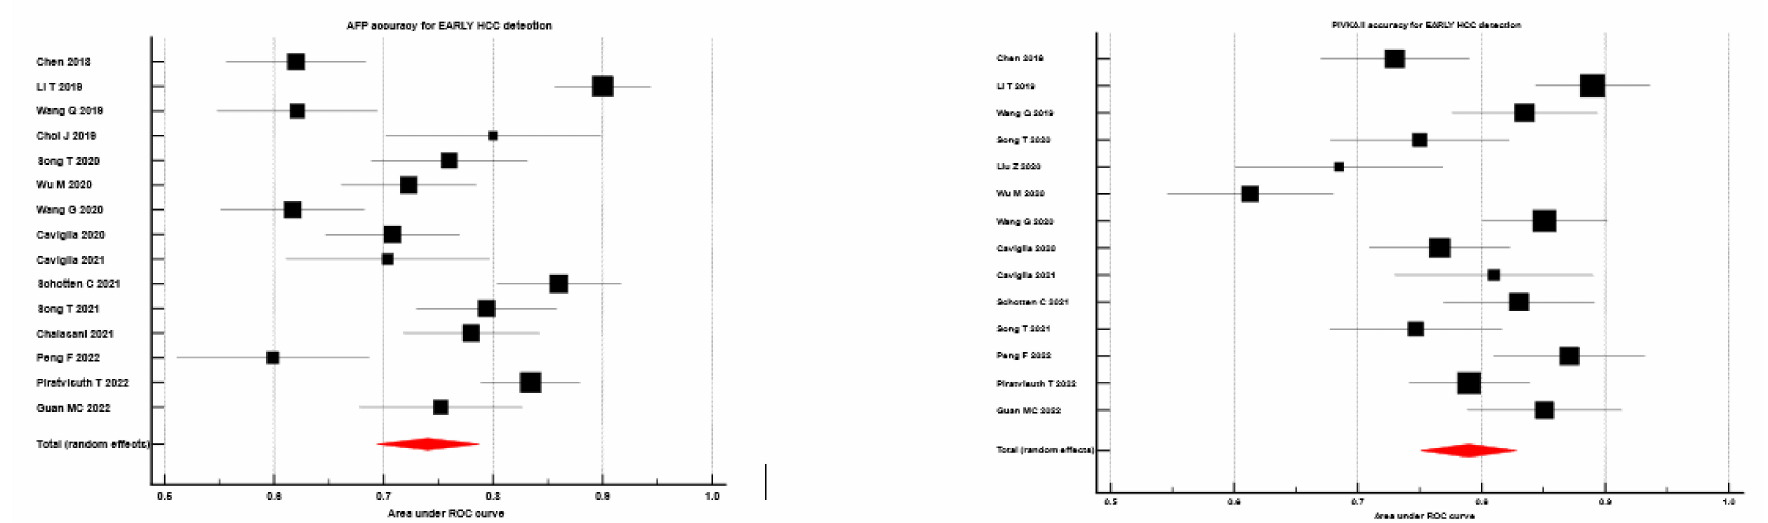
Figure 3. Forrest plot of AFP vs. PIVKA II accuracy for EARLY HCC detection; Left panel of figure-red marker–AUROC for AFP determined by meta-analysis; right panel of figure-red marker–AUROC for PIVKA II determined by meta-analysis. References Chen 2018 [66], Li T 2019 [78], Wang Q 2019 [77], Choi J 2019 [54], Song